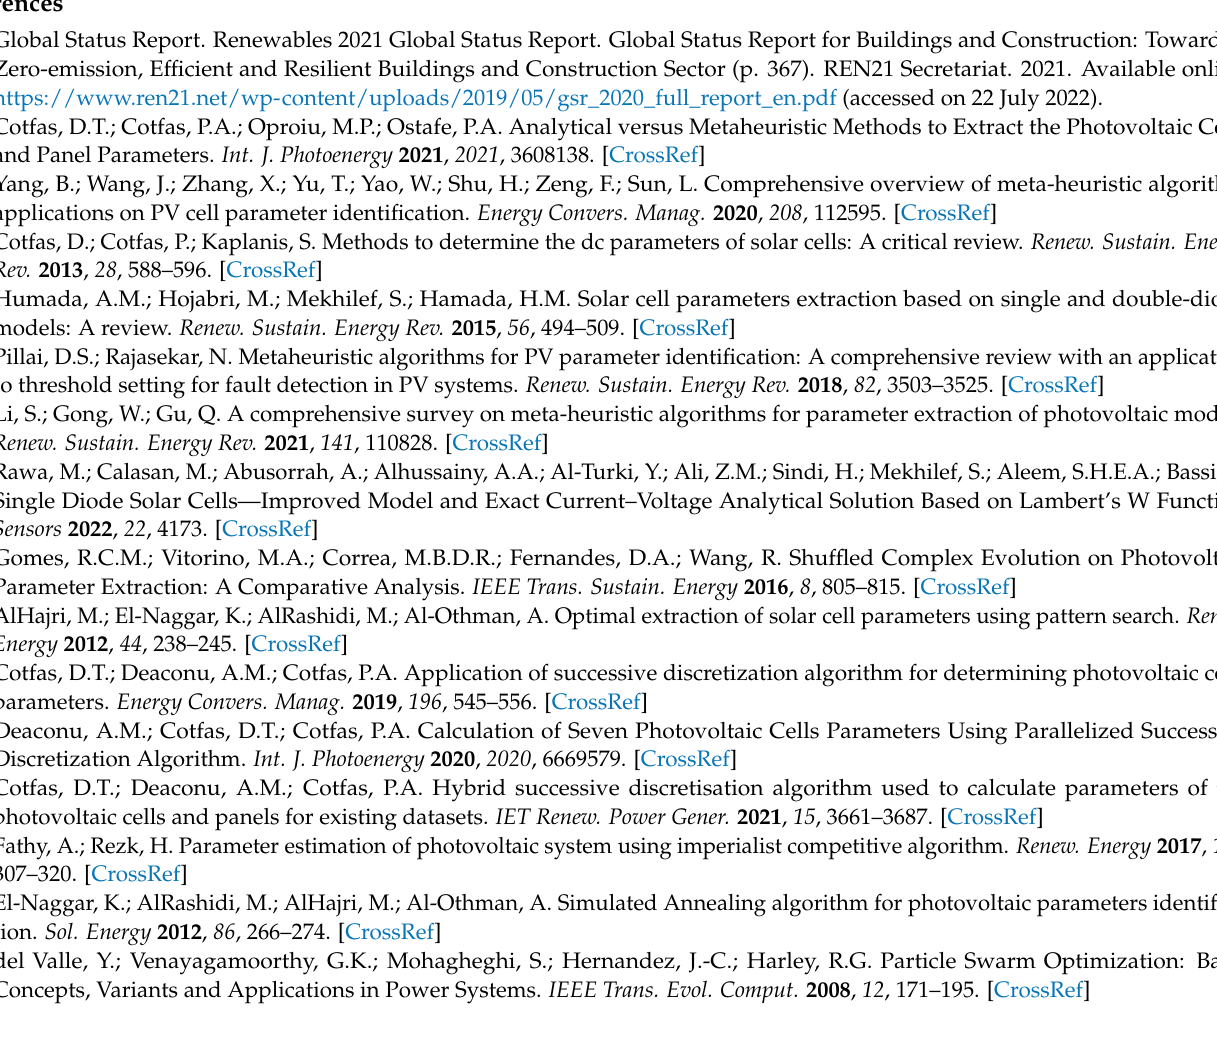
R250A5 photovoltaic panel for 30 populations; Table S34: Sharp ND-R250A5 photovoltaic panel parameters and range for 30 populations; Table S35: (I, V) points of Sharp ND-R250A5 photovoltaic panel for 15 populations; Table S36: Sharp ND-R250A5 photovoltaic panel parameters and range for 15 populations; Table S37: (I, V) points of Kyocera KC200GT photovoltaic panel for 500 epochs; Table S38: Kyocera KC200GT photovoltaic parameters and range for 500 epochs; Table S39: (I, V) points of Kyocera KC200GT photovoltaic panel for 30 populations; Table S40: Kyocera KC200GT photovoltaic parameters and range for 30 populations; Table S41: (I, V) points of Kyocera KC200GT photovoltaic panel for 15 populations; Table S42. Kyocera KC200GT photovoltaic parameters and range for 15